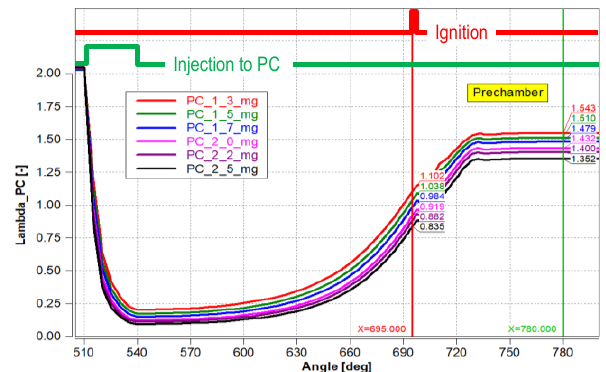
Fig. 4. Prechamber fuel dose values and the determined  values during ignition in the prechamber The mean value of the air excess coefficient in the com- bustion chamber is reduced proportionally to the increasing fuel dose value q . When the combustion process begins o_PC the  value is not constant – it increases as a result of mass flow from the main chamber to the prechamber. The chan- ges in  were determined based on the selection of the PC_ign q value. These trends are shown in Fig. 5. It can be seen o_PC that the adopted strategies for changing the air excess coef- ficient for (global) combustion of lean mixtures maintained it around  = 1.